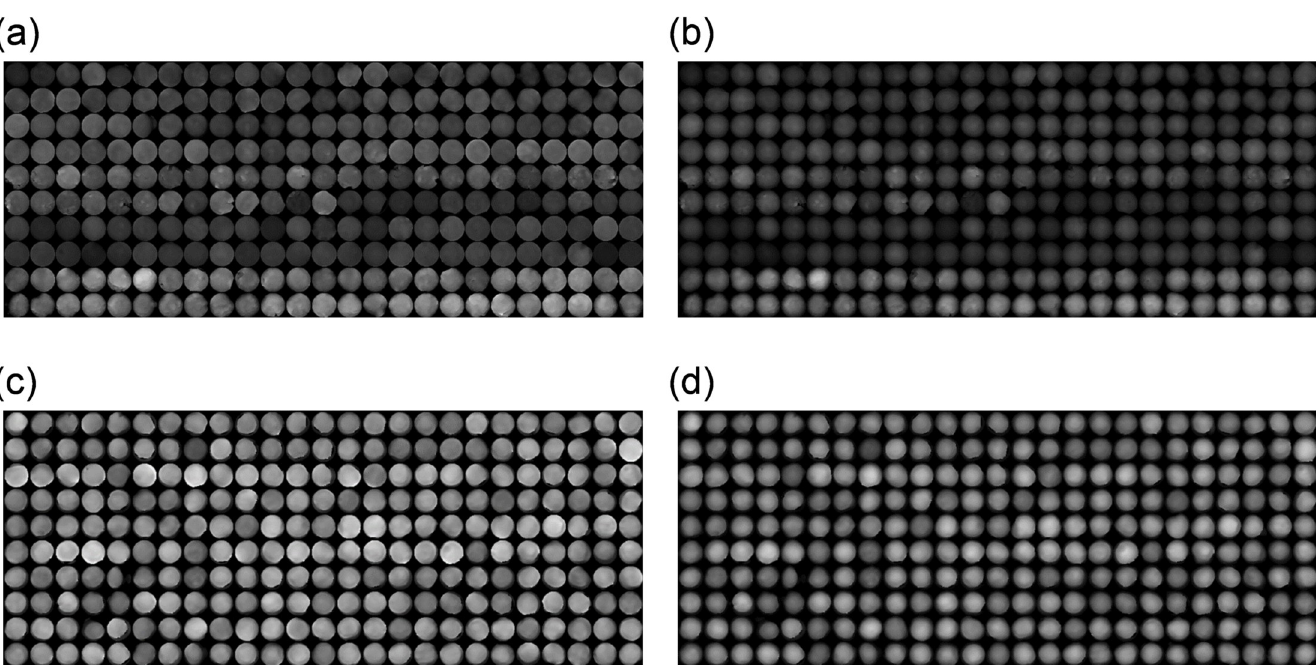
Fig 6. All QPM images (OPL) normalized by path-length or diameters. (a) OPL/PL: QPM images normalized by path lengths of cell lines; (b) OPL/D: QPM images normalized by diameters of cell lines; (c) OPL/PL: QPM images normalized by path lengths of WBCs; and (d) OPL/D: QPM images normalized by diameters of WBCs.